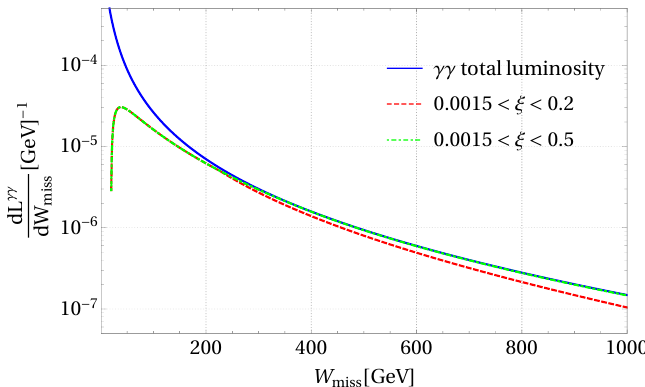
Figure 1 . Photon-photon luminosity versus two-photon invariant mass at 13 TeV for total and FD